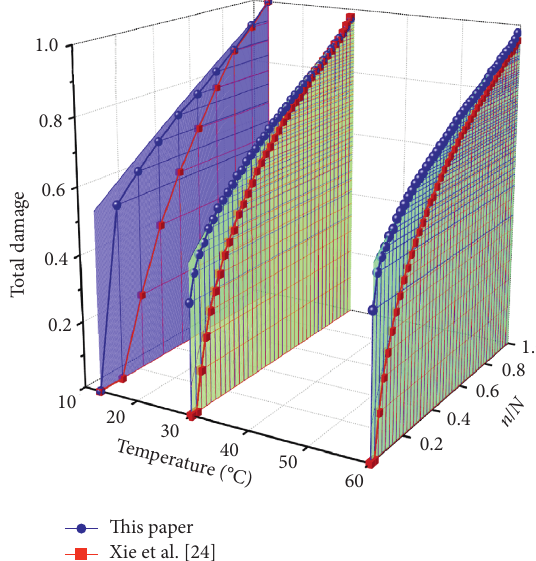
Figure 9: Comparison of fatigue damage